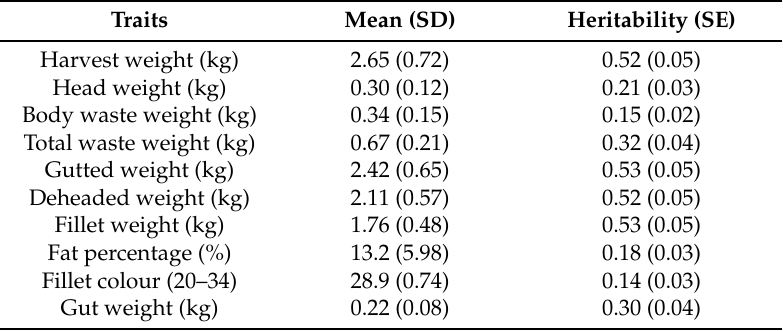
Table 1. The summary statistics and heritability estimates for the harvest traits.